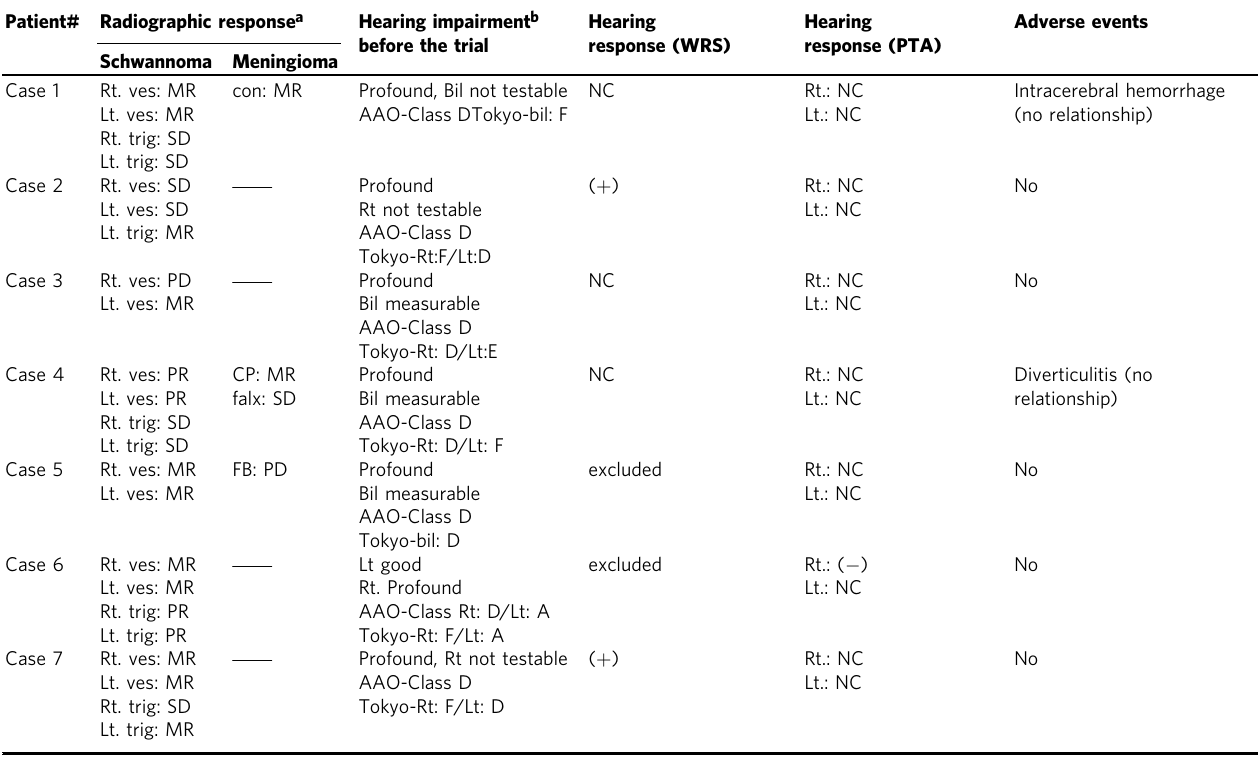
Table 2 Patient outcome. Patient# Radiographic response